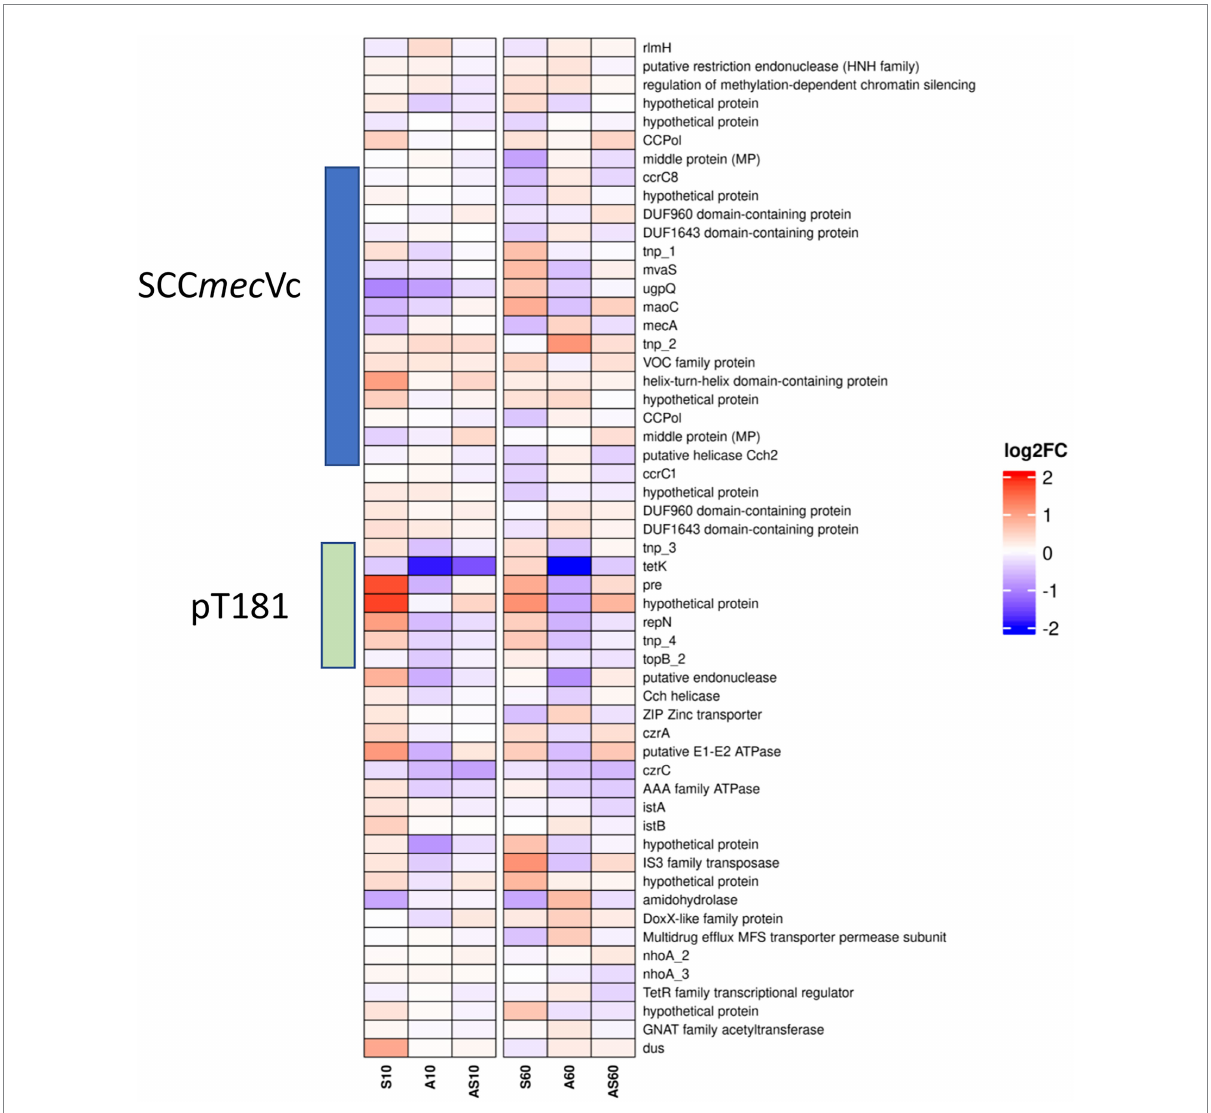
FIGURE 6 Heatmap illustrating transcription of genes at the chromosomal SCC mec integration site from rlm H (“ orf X”) to dus (“ orf Y”). Gene transcripts are visualized based on their log2 fold-change (log2FC) with either red (upregulated), blue (downregulated) or white (no changes) compared to the corresponding control samples. Each column corresponds to a growth condition (S = serum, A = ammonia, AS = ammonia & serum) and time point (10 min and 60 min). Overall expression ranges from-2 log2FC to +2